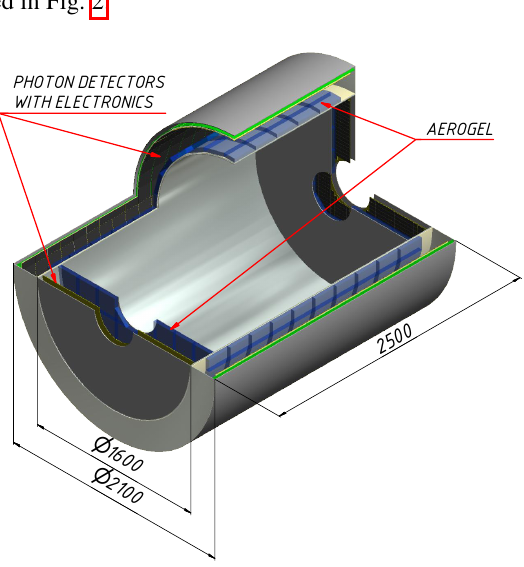
Figure 2. The scheme of the SCT detector FARICH